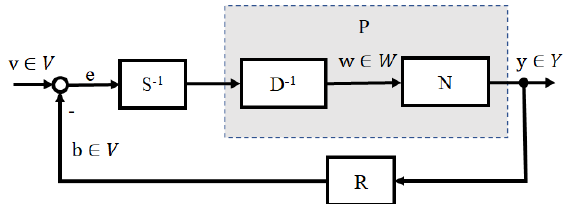
Figure 2. Right coprime factorization of a nonlinear